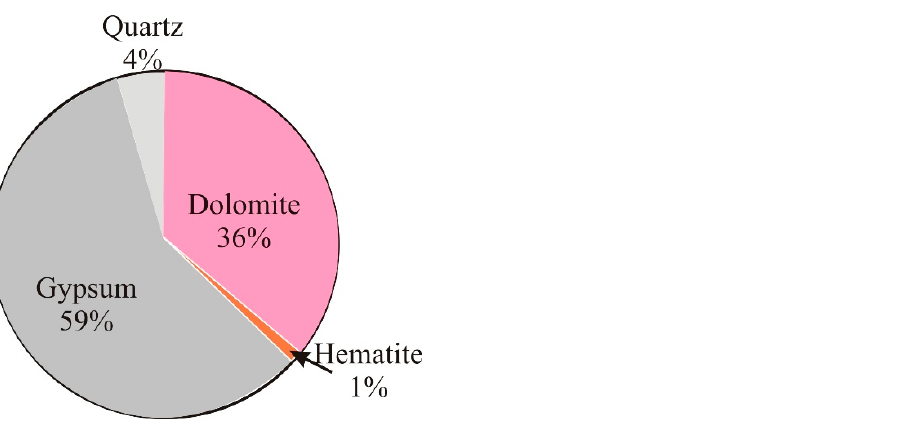
Figure 9. Estimated mineral composition of sediments from the solution of the settling pond (A01).